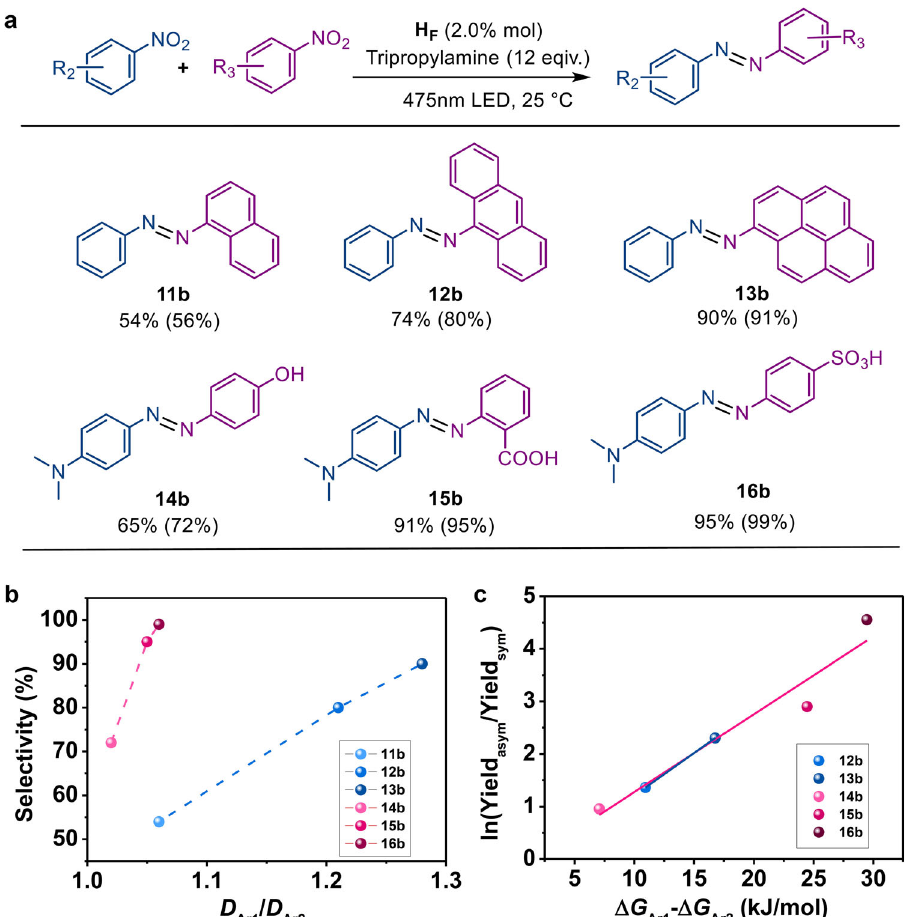
Fig. 8 Selective condensation of nitroarenes into asymmetric azo products. a Selective condensation of nitroarenes into asymmetric azo showing the isolated yields with the selectivity in parentheses under standard conditions: H F (0.5 µ mol), equimolar amounts of nitroarenes substrates (0.025 mmol) and tripropylamine (0.60 mmol) for the irradiation of 6 h. b The relationship between the selectivity of the asymmetric azo products over the symmetric ones and the ratio of the diffusion coef fi cients corresponding to the nitroarenes. c The relationship between the yield ratio of the asymmetric azo compounds (yield asym ) over the symmetric ones (yield sym ) showing as ln(yield asym /yield sym ) and the difference of Gibbs free energy changes corresponding to the two nitroarenes within the microenvironment catalyst H F. (The Gibbs free energy changes corresponding to nitrobenzene and N, N ’ - dimethyl-4-nitroaniline were just used as